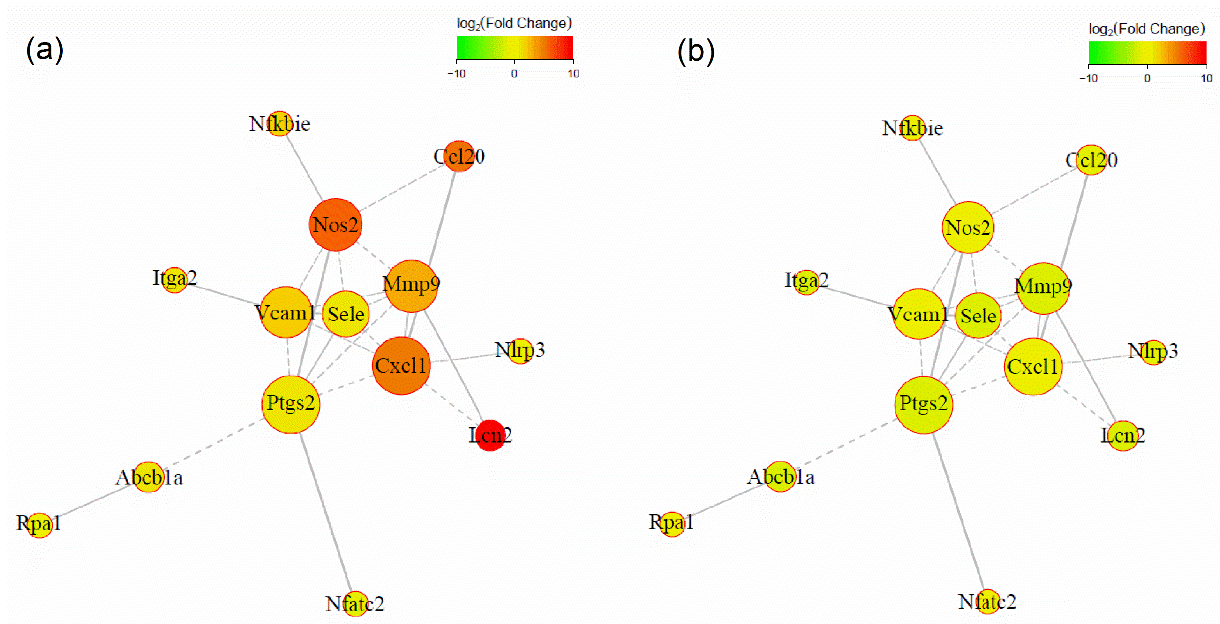
Figure 5. PPI network for the overlapped differentially expressed genes: ( a ) LPS vs. control group; ( b ) 6-shogaol vs. LPS group. Nodes represent proteins and edges represent interactions between two proteins. The size of proteins indicates node degree value. Solid lines indicate that the relationship between genes has been verified, and dashed lines indicate that it has not.